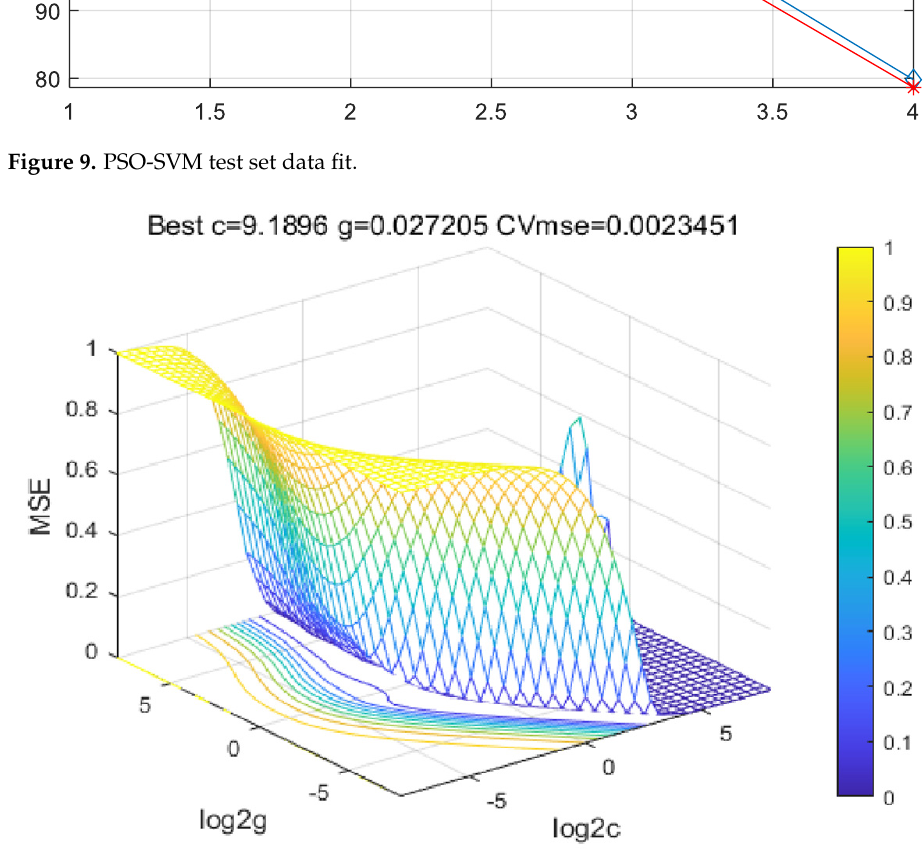
Figure 10. Grid-cg parameter optimization 3D view.